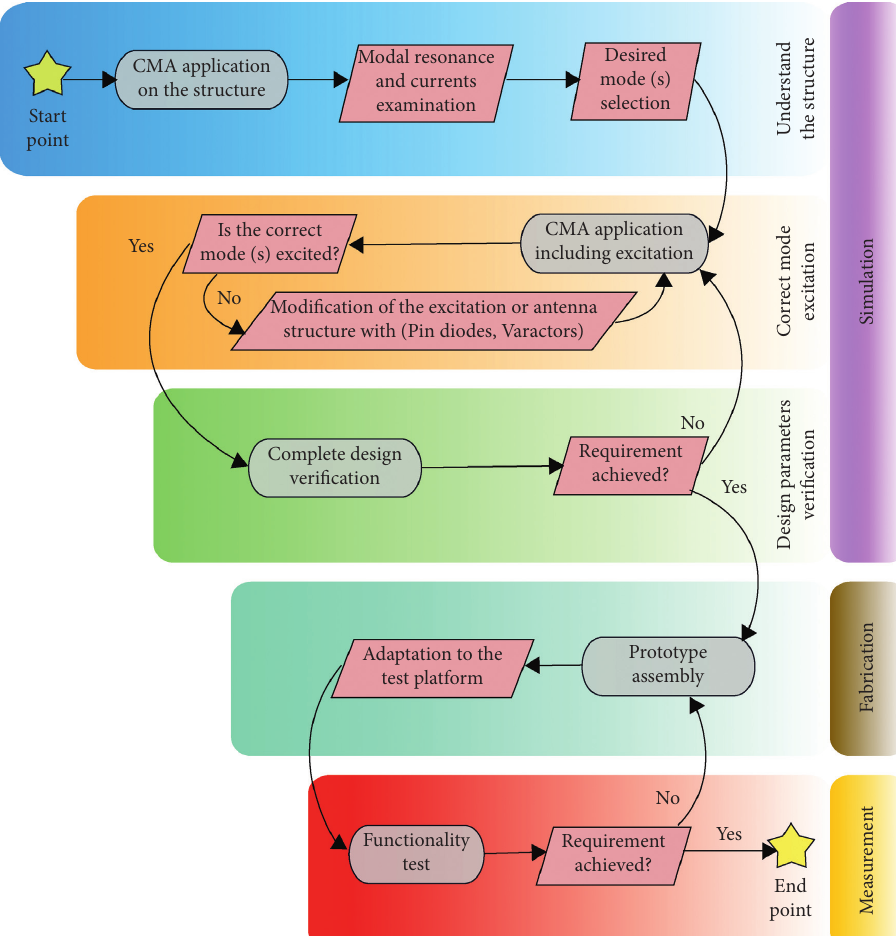
Figure 1: Workflow of a reconfigurable antenna design based on CMA.